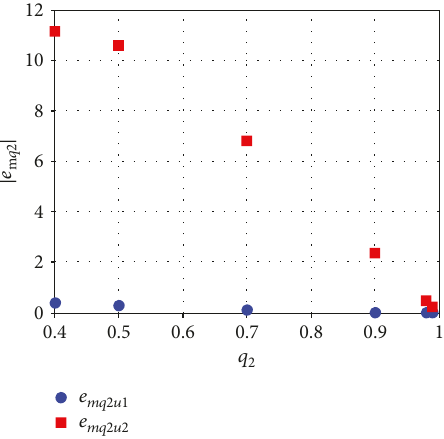
Figure 12: Deviation of the desired maximum amplitudes of oscillation with the proposed control for variations in q 2 = 0 4 , q 2 = 0 5 , q 2 = 0 7 , q 2 = 0 9 , q 2 = 0 98 , and q 2 = 0 99 . (a) Deviation of the desired maximum amplitudes of oscillation e 1 and (b) deviation of the desired maximum amplitudes of oscillation = u − u u e 2 2 q 2 2 q 2 q 2